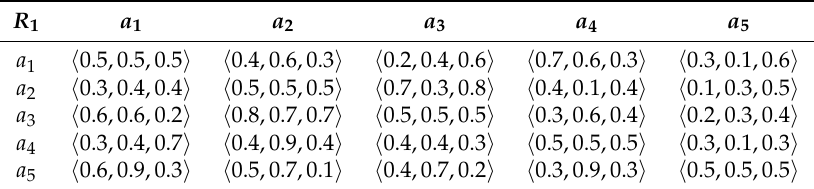
Table 1. SVNPR of the expert from the engineering management department.